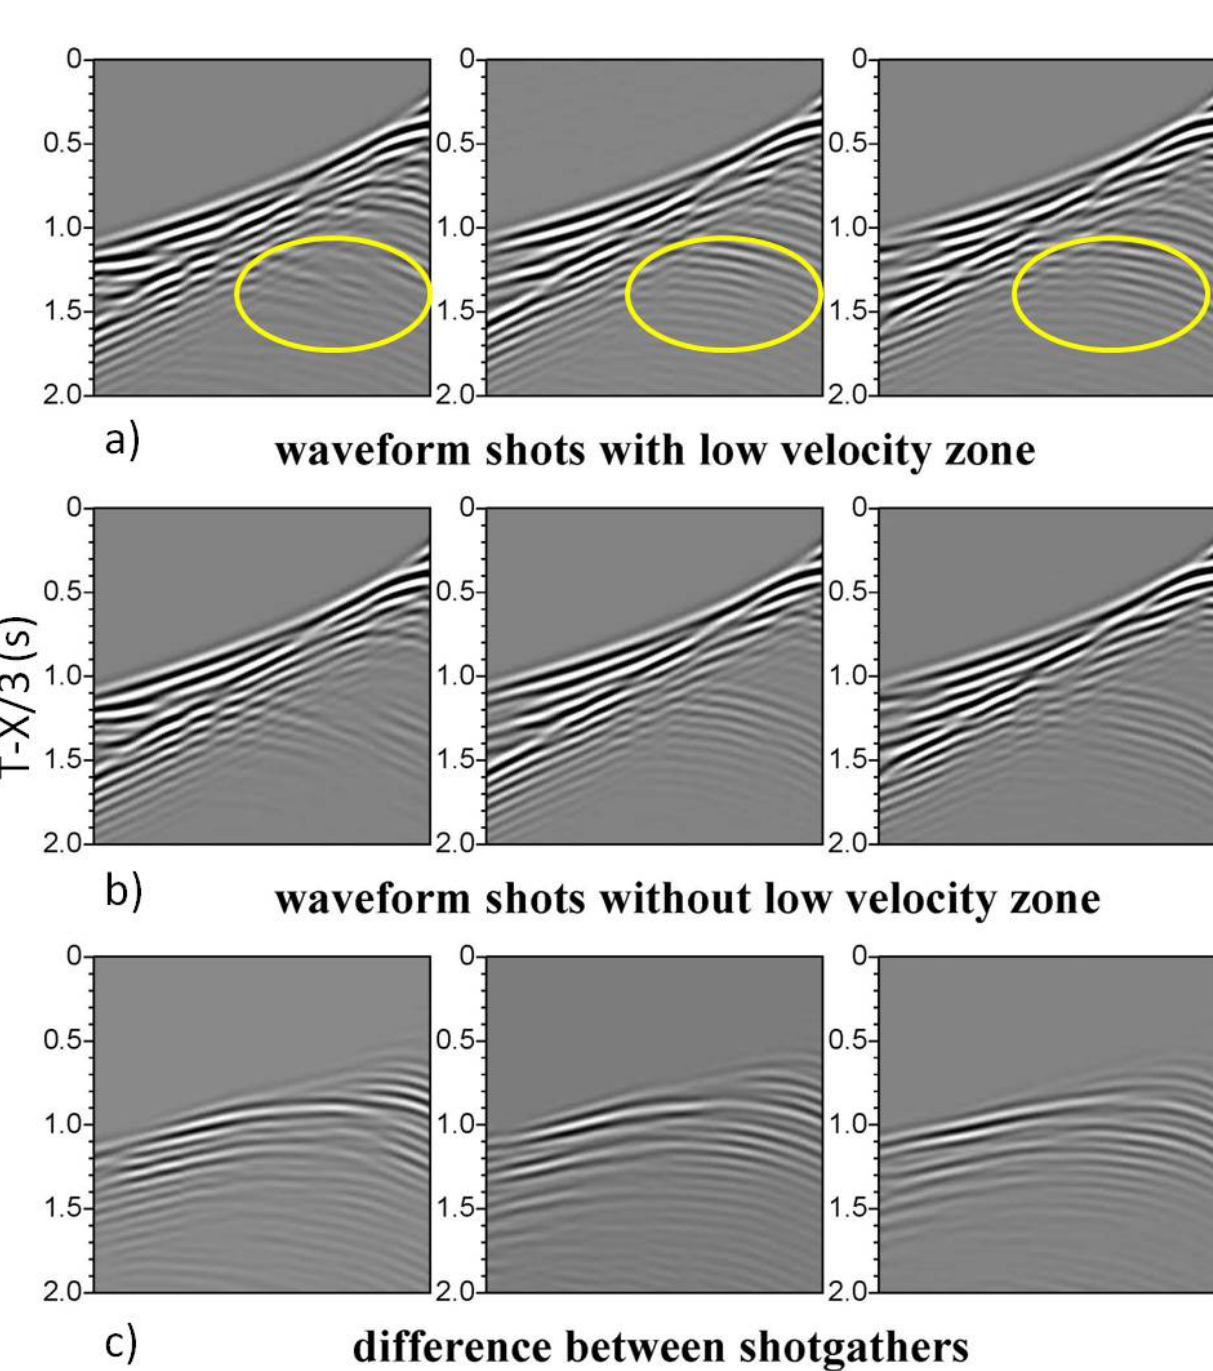
Figure 13. Synthetic shot gathers using FWI velocity model at model distance 6 km, 8 km, 10 km. ( a ) With low velocity zone, ( b ) without low velocity zone, and ( c ) difference between ( a , b